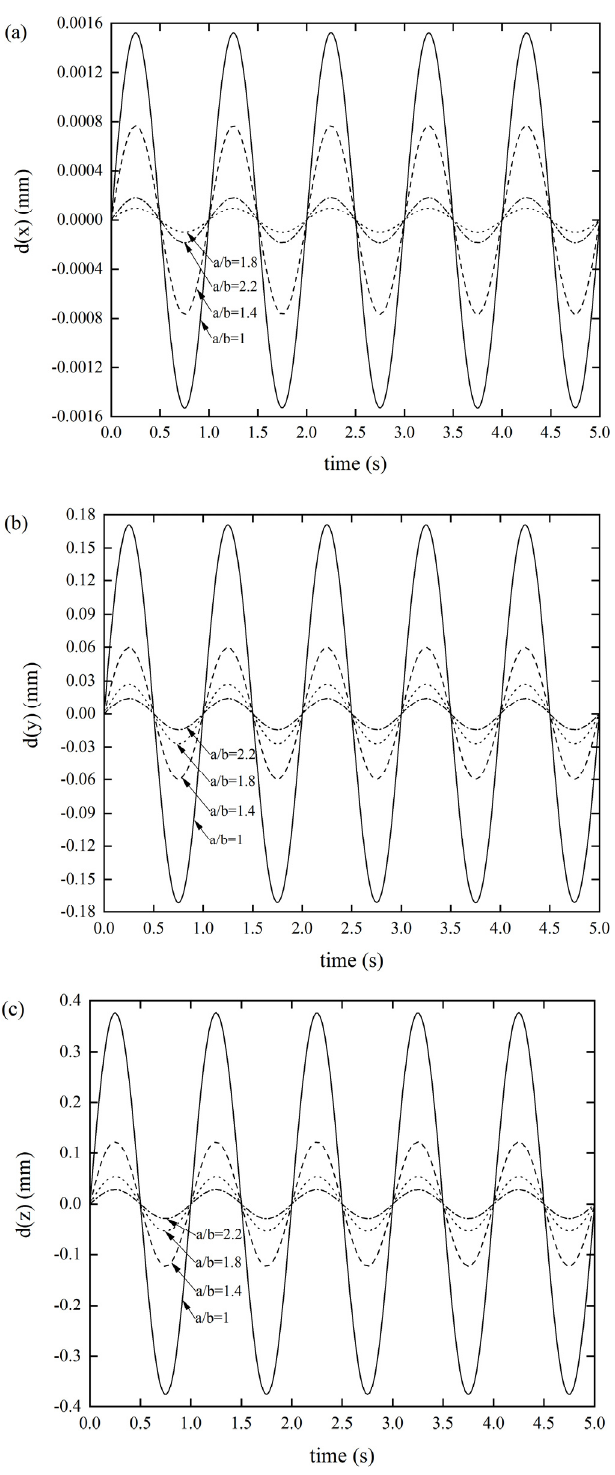
Figure 7. DDR of the Miura tube for different side length ratios of parallelogram a / b ( θ = 130 ° , t = 0.6mm) ( a ) x -displacement of the Miura tube under force along the x -direction, ( b ) y -displacement of the Miura tube under force along the y -direction, and ( c ) z -displacement of the Miura tube under force along the z -direction.